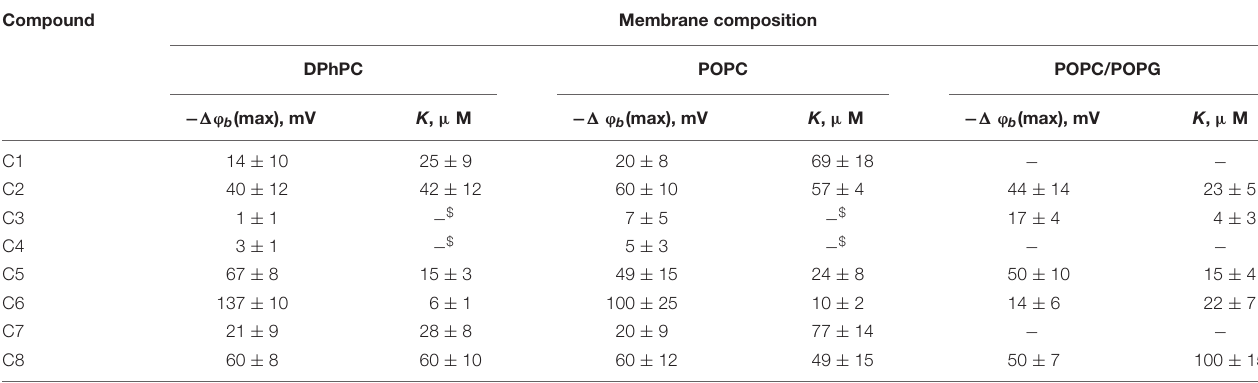
TABLE 2 | Characteristic parameters of the Langmuir adsorption isotherms used to describe the adsorption of 1,3-thiazine, 1,2,3,4-dithiadiazole, and thiohydrazide derivatives on lipid bilayers with different compositions. Compound Membrane composition DPhPC POPC